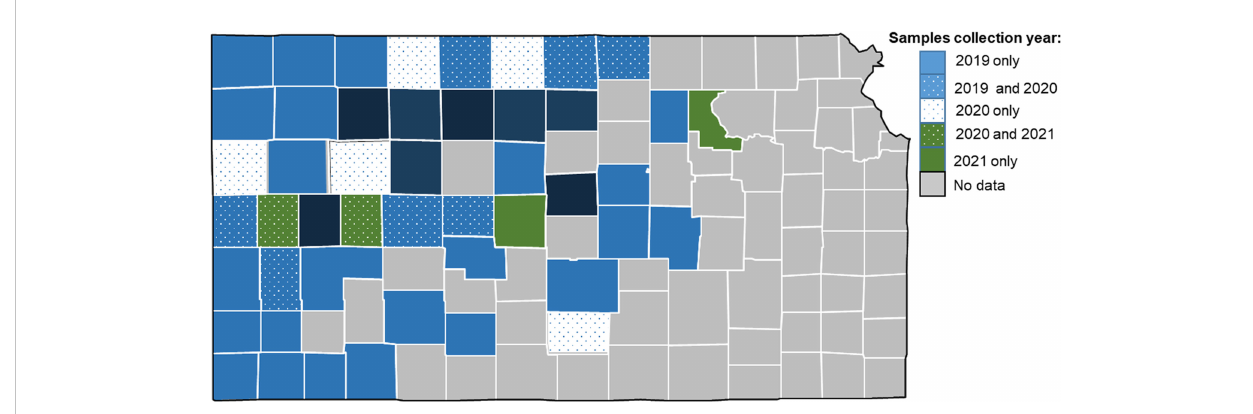
FIGURE 1 Map of Kansas counties where samples were collected in 2019, 2020, and 2021. Counties with no data indicates never sampled during this